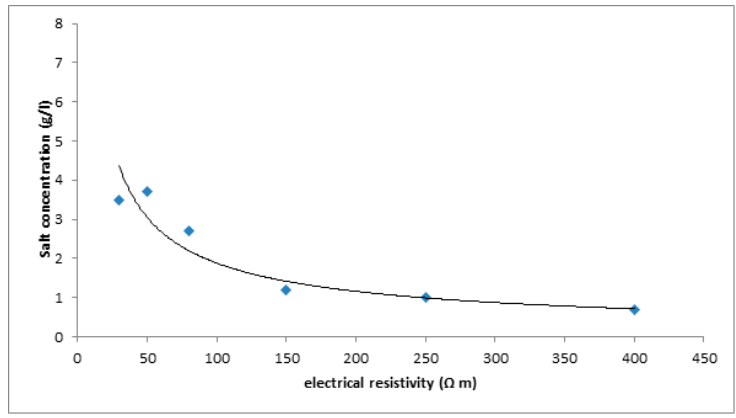
Figure 4. The relationship between electrical resistivity ( ρ ) and groundwater salt concentration ( C salt ) at the Bari coastal aquifer.